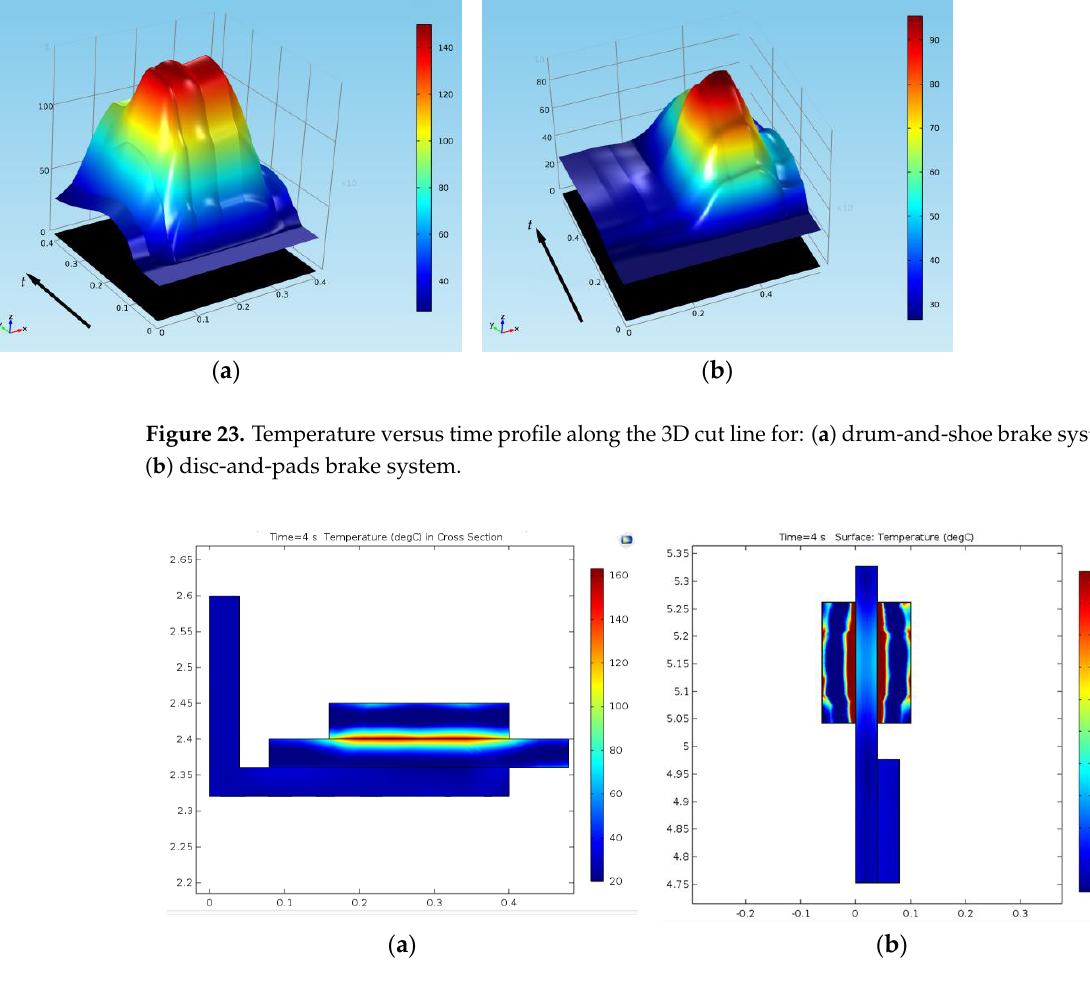
Figure 24. Temperature in cross-section for: ( a ) drum-and-shoe couple; ( b ) disc-and-pads